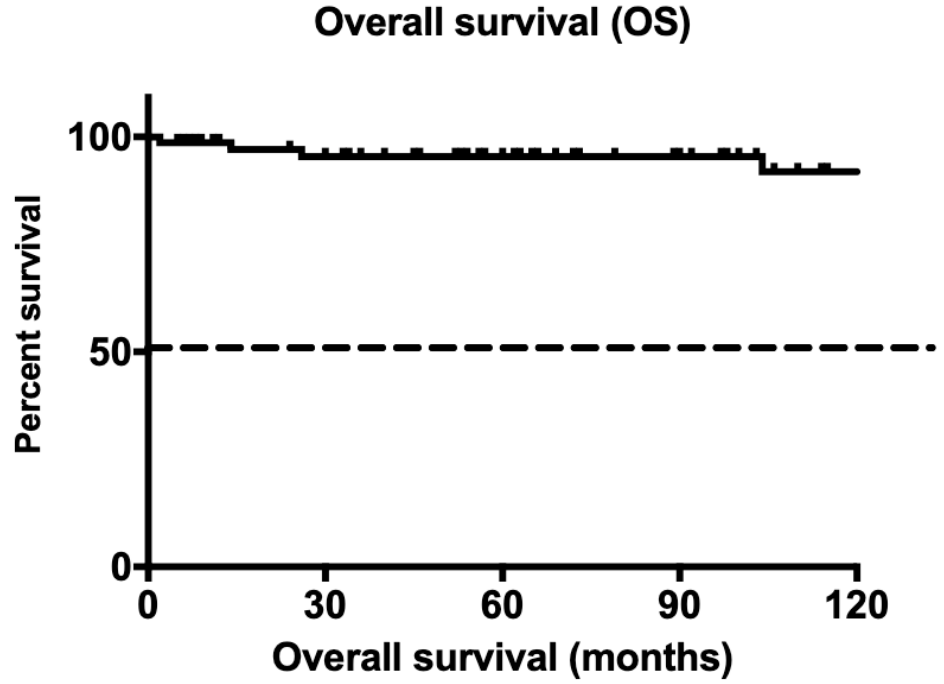
Figure 1. Kaplan Meir curve for overall